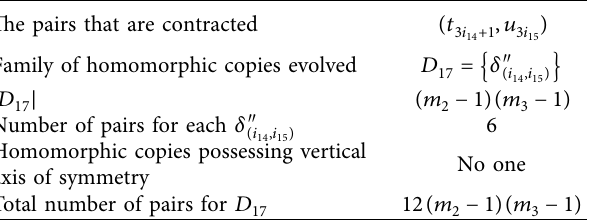
Table 17: Necessary information regarding homomorphic copies